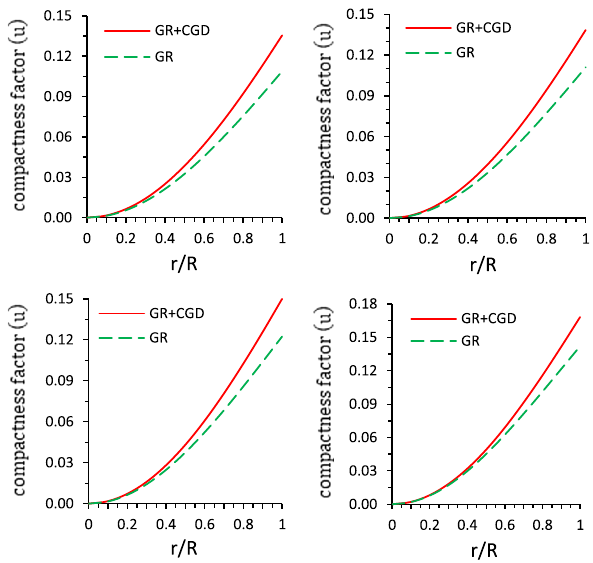
Fig. 7 The trend of the compactness u = m ( r )/ r versus the radial coordinate r / R . Each figure is showing the comparison between GR+EGD and pure GR scenario for different compact objects. Top left and top right figures for 4U 1538-52 and SAX J1808.4-3658, respec- tively while bottom left and bottom figures represent corresponding to compact objects for SMC X-1, and LMC X-4. For plotting of the above figures, we have chosen the values of free parameters as D = 0 . 0022 and A = 0 . 0031